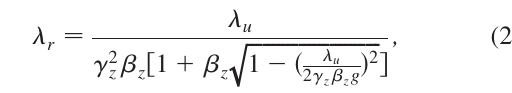
(cid:1) 300 – 320 (cid:6) m . The harmonic band centers are located at (cid:1) 100 and C